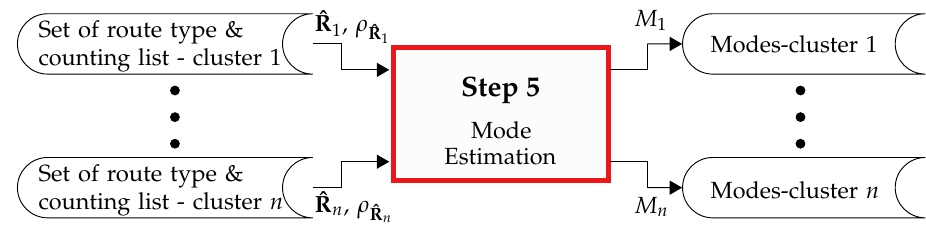
Figure 12. Overview of step 5 of the PROMOTING method: the mode estimation.